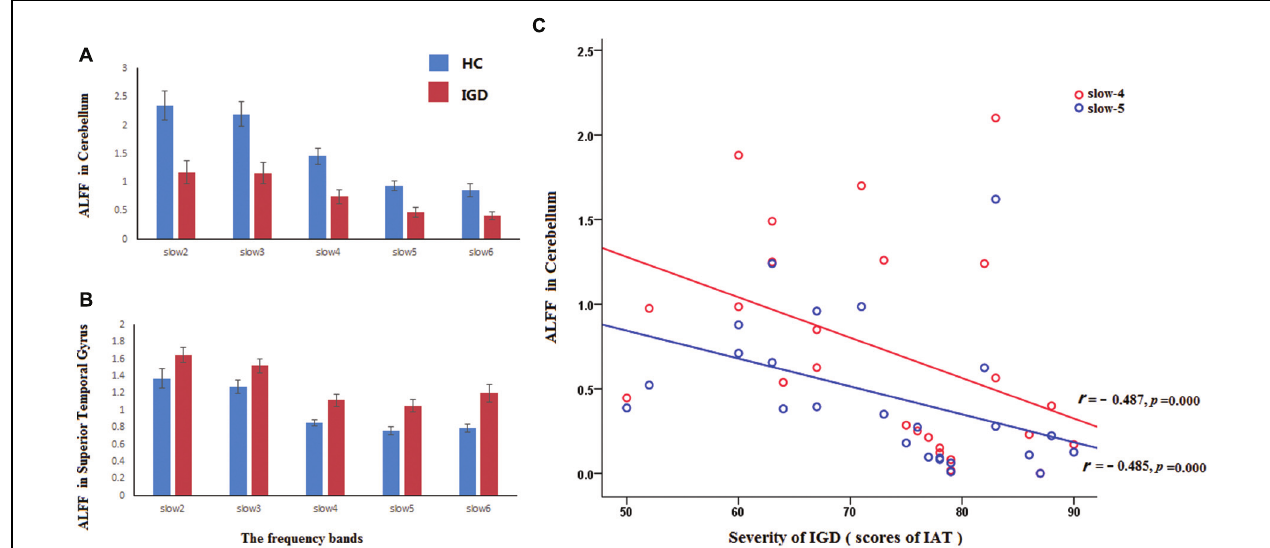
FIGURE 2 | The ALFF values in superior temporal gyrus and the cerebellum. The red and blue rectangle represented IGD subjects and healthy controls, respectively. The full frequency band (0–0.25 Hz) was divided into five bands. They were displayed in (A,B) [slow-6 (0–0.01 Hz), slow-5 (0.01–0.027 Hz), slow-4 (0.027–0.073 Hz), slow-3 (0.073–0.198 Hz), and slow-2 (0.198–0.25 Hz)]. (C) Reveled the ROI-based correlation between the severity of IGD and the ALFF values in the cerebellum, the red and blue line represented frequency slow-4 and slow-5, respectively.